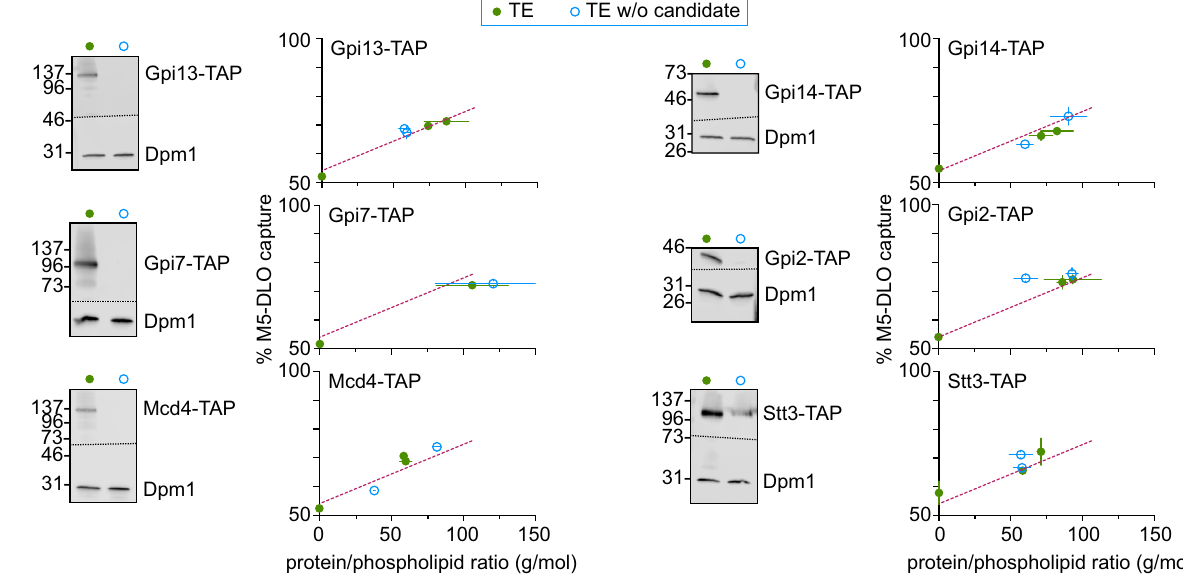
Figure 4. Evaluating M5-DLO scramblase candidates by immunodepletion. TE was prepared from yeast strains expressing a C-terminally TAP-tagged variant of the scramblase candidate in place of the endogenous protein. Tagging was done at the genomic locus. Six unique TE preparations were thus generated, corresponding to cells expressing Gpi13-TAP, Gpi7-TAP, Mcd4-TAP, Gpi14-TAP, Gpi2-TAP or Stt3-TAP. In every case the extract was mock-treated (green filled circles) or incubated with IgG-agarose beads to remove the TAP-tagged protein (blue open circles). Removal of the TAP-tagged protein from the extract was confirmed by SDS-PAGE/ immunoblotting using anti-TAP antibodies, and specificity of immunodepletion and equivalence of sample loading was confirmed by immunoblotting to detect the ER resident membrane protein Dpm1. Mock-treated and depleted extracts were reconstituted and assayed for M5-DLO scramblase activity. Reconstitutions were performed at different ratios of protein to phospholipid, in the approximate range 25–125 g/mol. The figure shows immunoblots paired with the corresponding activity assays for each candidate. Error bars are obtained from duplicate measurements of activity, as well as duplicate measurements of the protein and phospholipid content of the reconstituted vesicles. The red dashed line, based on all data from the mock-treated samples, is intended to guide the eye. See Fig. S5 for uncropped versions of the